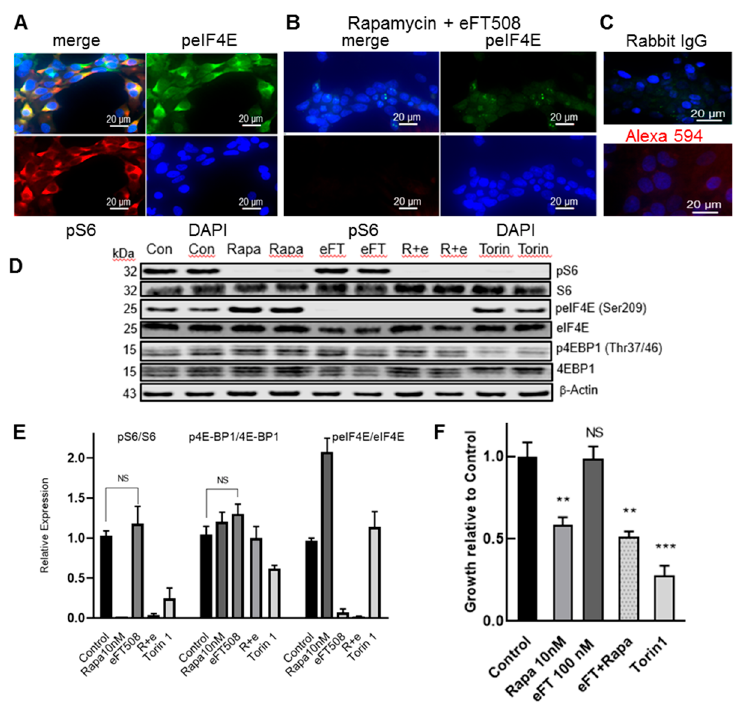
Figure 3. MNK1 / 2 inhibitor eFT508 inhibits peIF4E but not growth in TSC2-null LAM patient-derived angiomyolipoma cells. ( A ) Immunofluorescent analysis of LAM patient-derived AML 621-102 cells. ( A ) Merge (yellow) of pS6 (Ser235 / 236) (red) and peIF4E (Ser209) (green), peIF4E alone (green), pS6 alone (red), and 2-(4-amidinophenyl)-1H-indole-6-carboxamidine (DAPI) DNA-stained blue nuclei. All are rabbit primary antibodies. ( B ) Pretreatment of 621-102 cells with Rapamycin (10 nM), plus eFT508 (1 µ M) peIF4E (green), pS6 (red), and DAPI (blue). ( C ) Control anti-rabbit IgG Alexa 488 and Alexa 594. ( D ) Immunoblot detection of pS6, S6, peIF4E, eIF4E, p4E-BP1, 4E-BP1, and β -Actin in 621-102 cells incubated for 16–18 h in a serum-deprived medium. The immunoblot represents data from three independent experiments with duplicate or triplicate samples. ( E ) Expression of pS6 / S6, p4E-BP1 / 4E-BP1, and peIF4E / eIF4E corrected for β -Actin expression in each lane and relative to the appropriate control, set as one. Error was calculated +/ − S.E.M and NS = Non-significant. ( F ) Growth inhibition of 621-102 cells, incubated in a medium containing 2.5% serum in 96 wells for 48 h, by rapamycin (10 nM) (Rapa) and Torin (500 nM), but not by eFT508 (100 nM) (eFT) and in combination (R + e). Cell growth was determined as described in Materials and Methods. Control growth absorbance 590 was set as one and drug inhibition was graphed relative to control. Graph F is representative of 4 independent studies in quadruplicate. Error was calculated +/ − SD and significance relative to control is shown as ** p < 0.01; *** p < 0.001 or